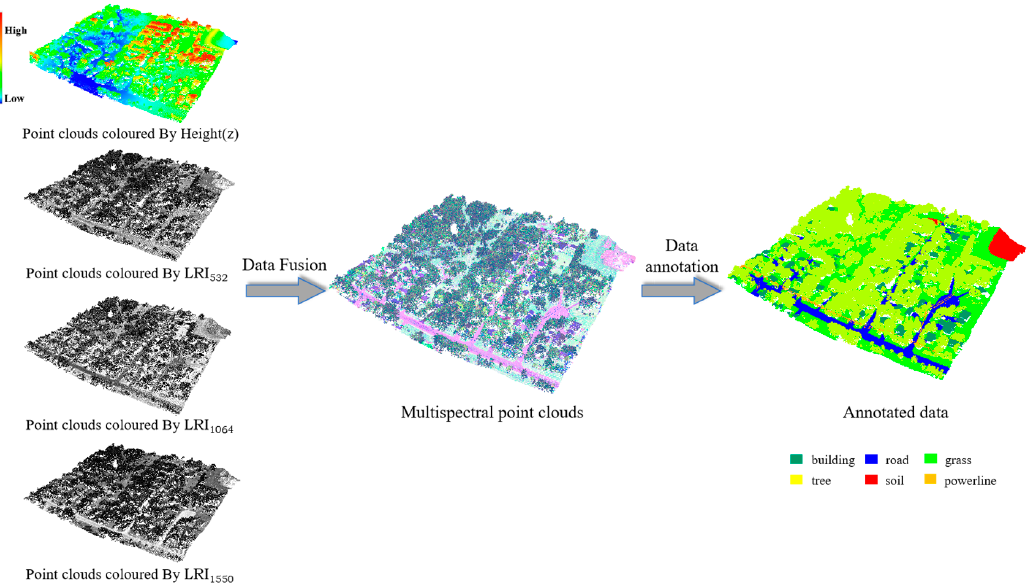
Figure 2. Data preprocessing of the Titan multispectral point clouds.